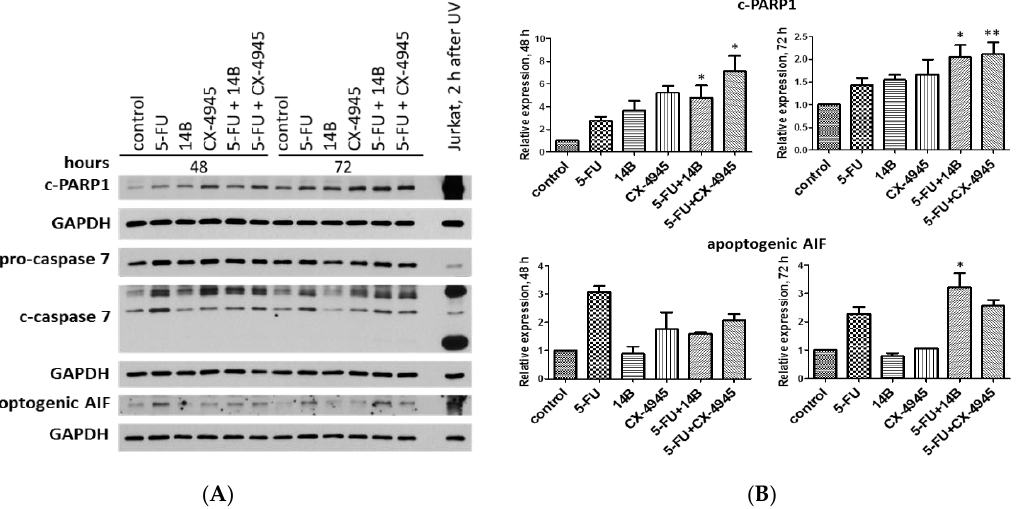
Figure 7. Western blot analysis of cleaved PARP1 (c-PARP1), the pro-form and active form of caspase 7 (pro-caspase 7 and c-caspase 7, respectively), and the apoptogenic form of apoptosis inducing factor (AIF) in crude extracts obtained from MDA-MB-231 cells after 48 h and 72 h of treatment with 15 µM 5-FU, 2 µM 14B, and 5 µM CX-4945, used separately or in combination. GAPDH was used as a loading control for each sample. ( A ) The representative blots; ( B ) densitometry quantifications for c-PARP1 and apoptogenic AIF are shown in the graphs, with untreated cells serving as the reference point (1). * Statistically, significantly different from that of 5-FU-treated cells and the drug combinations by student’s t -test ( p ≤ 0.05) (see Materials and Methods). Extract from UV-treated Jurkat cells was used as a positive control. After 2 h, one-minute UV-irradiated Jurkat leukemic T-cell line was lysed and subjected to analysis.